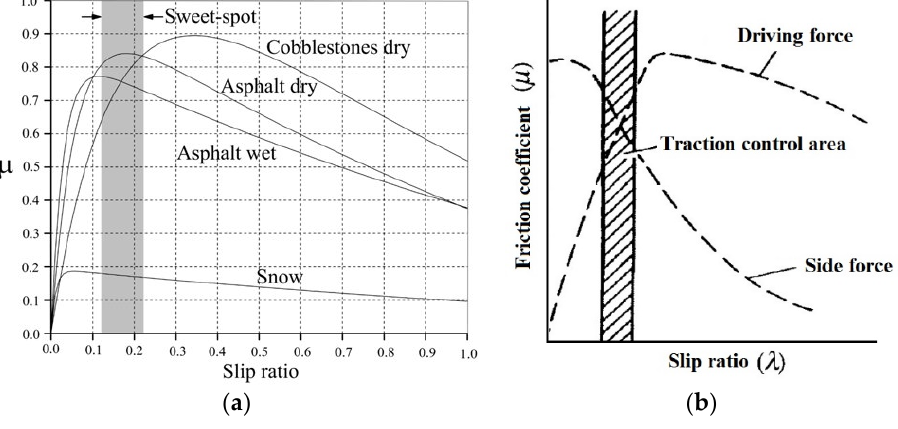
Figure 2. ( a , b ): pavement friction coefficient versus slip ratio [16,17].